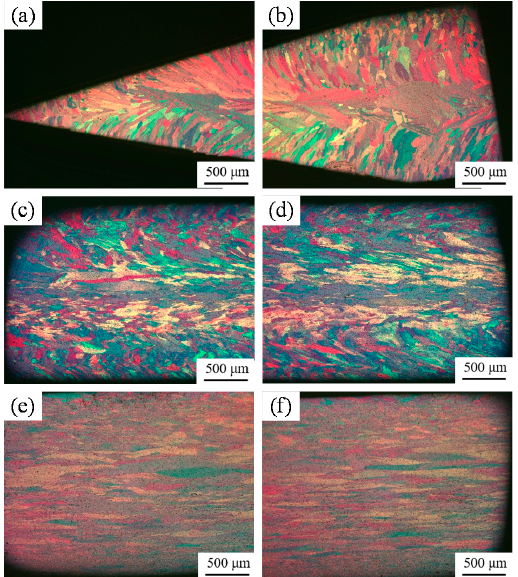
Figure 3. Grain structure of 1561 aluminum alloys after the hot rolling. ( a , b ) initial undeformed region; ( c , d ) the H1 plate; ( e , f ) the H2